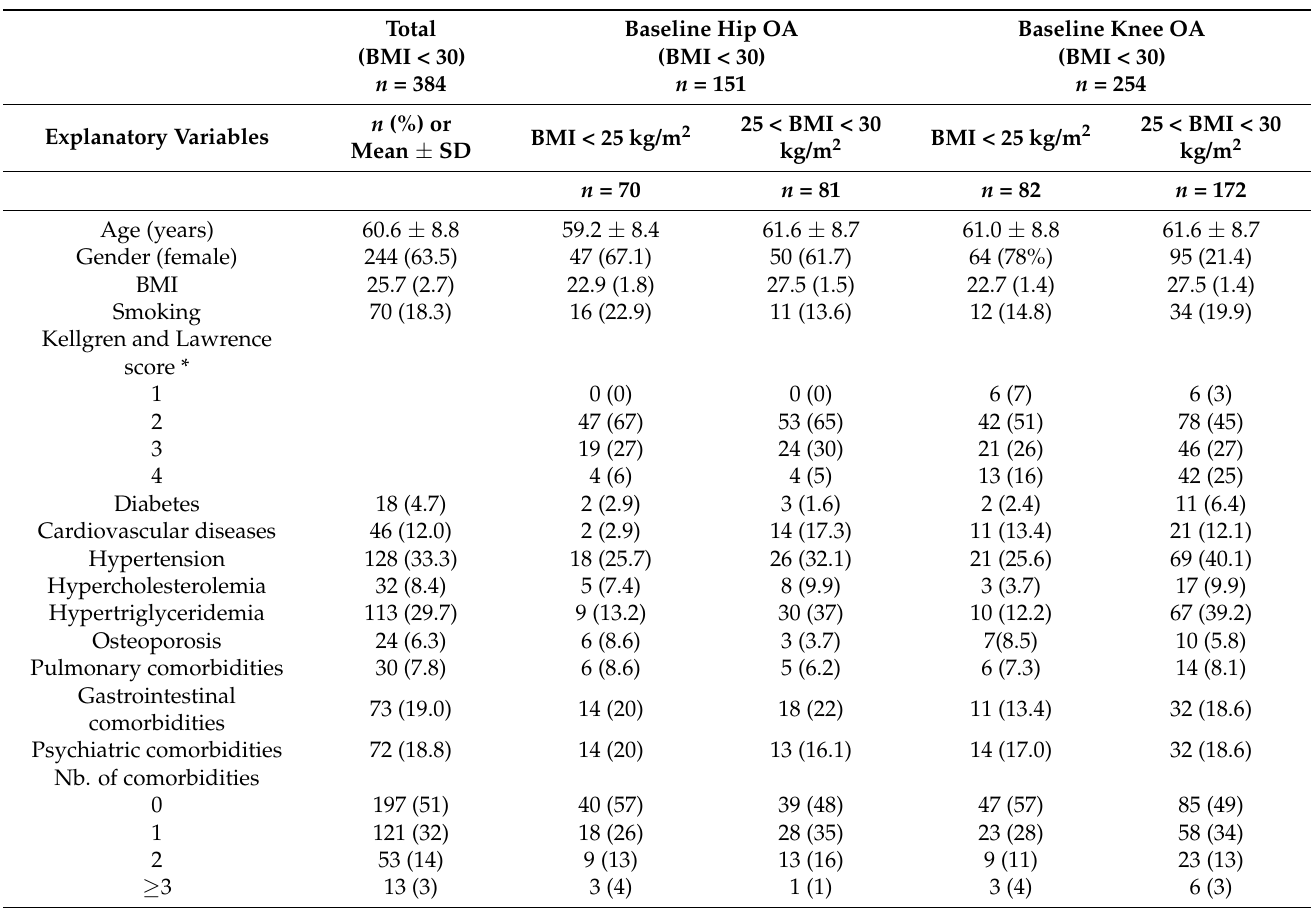
Table 1. Baseline participants demographic and clinical characteristics (data are presented as mean ± standard deviation (SD) or percentage (%) where appropriate).